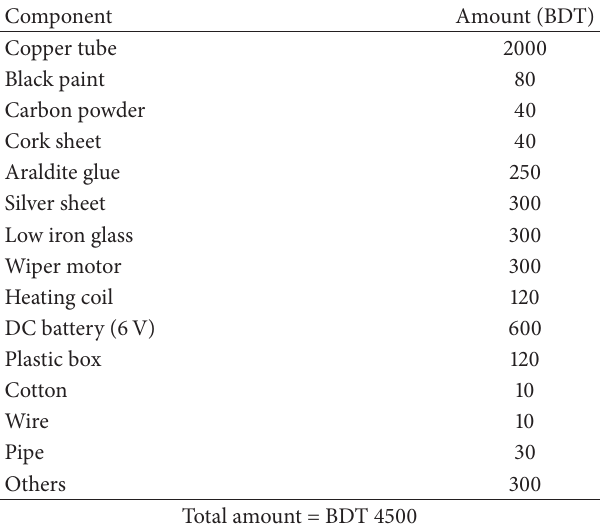
Table 3: Cost estimation of the proposed solar water heating